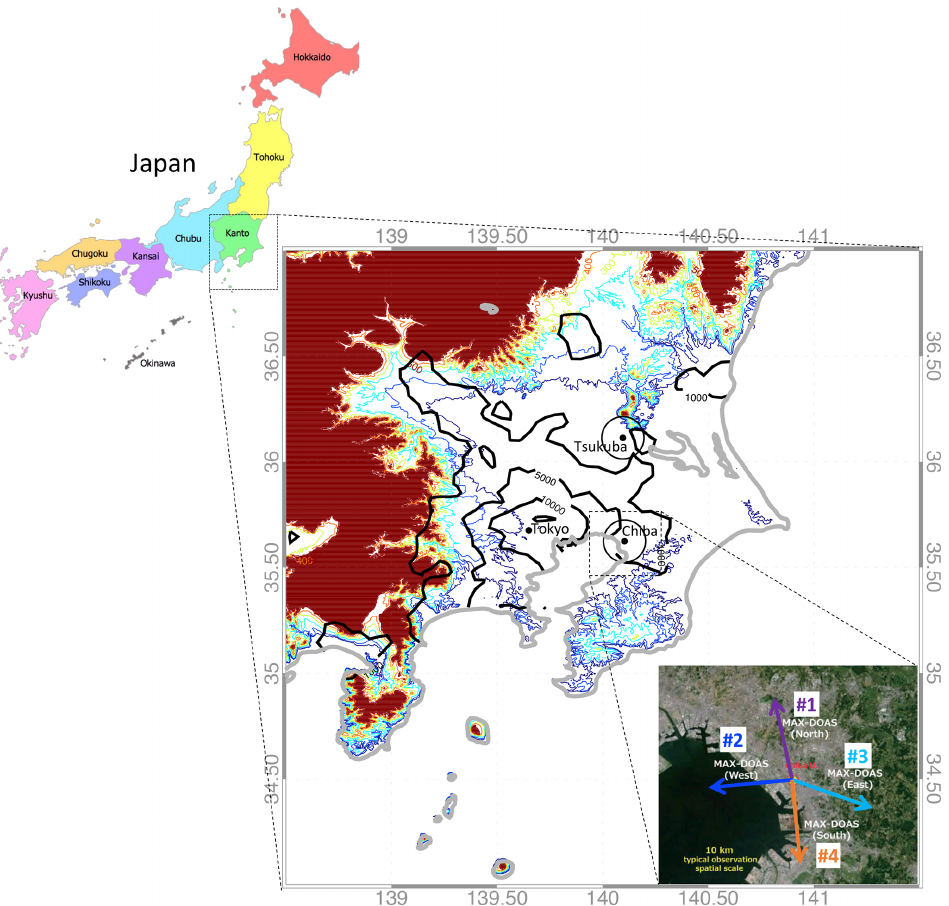
Figure 2. Main panel: terrain map (meters above sea level, colored isolines; elevations > 0 . 5km shaded dark red) from the General Bathy- metric Chart of the Oceans (GEBCO) 2021 and population density (black isolines, people per square kilometer) from the Gridded Population of the World Version 4 (GPWv4). Circles highlight the average area sampled by the MAX-DOAS system (four azimuthal directions for Chiba, one direction for Tsukuba). The top inset shows the location of the investigated Kanto region in Japan, and the bottom inset (© Google Maps 2019) shows the azimuthal pointing directions of the four MAX-DOAS systems deployed at Chiba